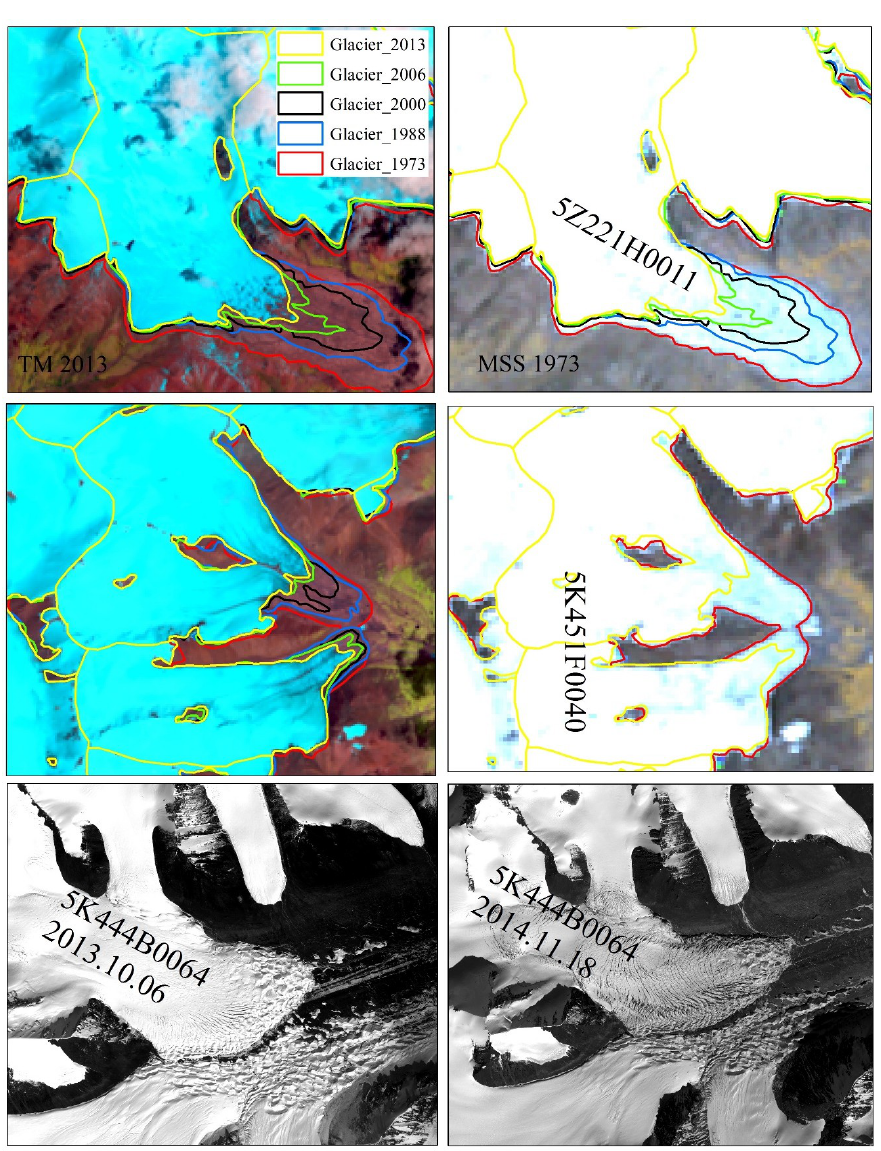
Figure 10. Changes of glaciers 5Z221H0011, 5K451F0040 and 5K444B0064 from 1973 to 2013.